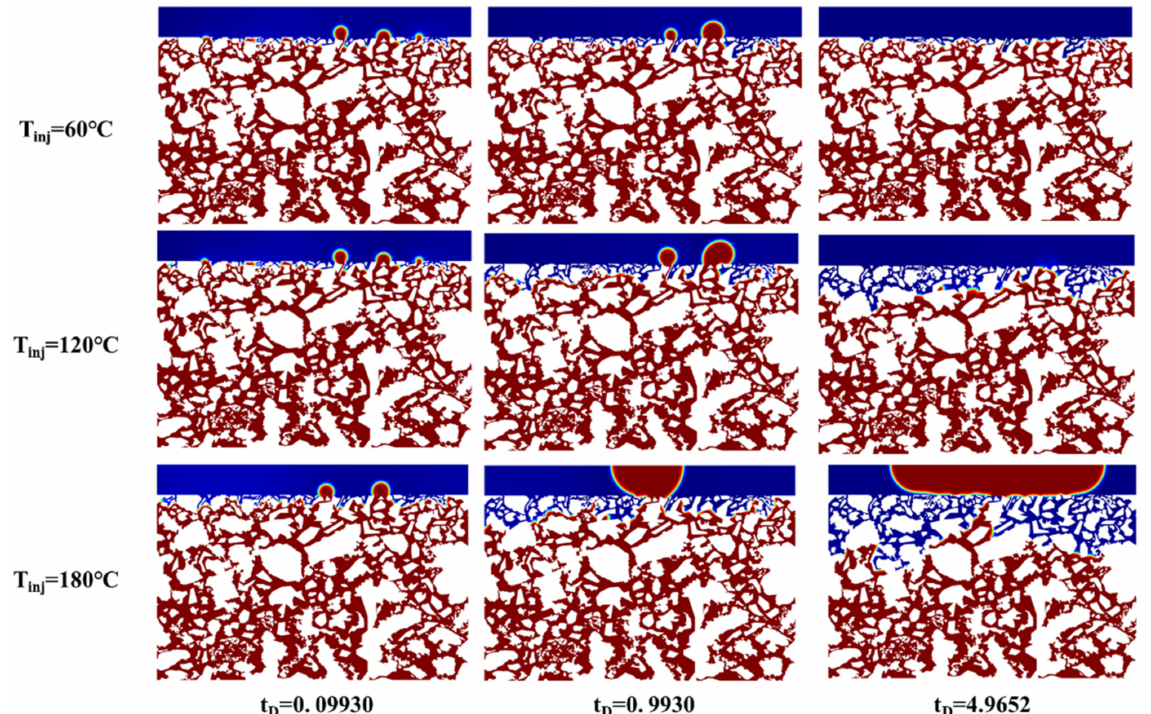
Figure 26. Oil-water distribution change with different injection temperatures.